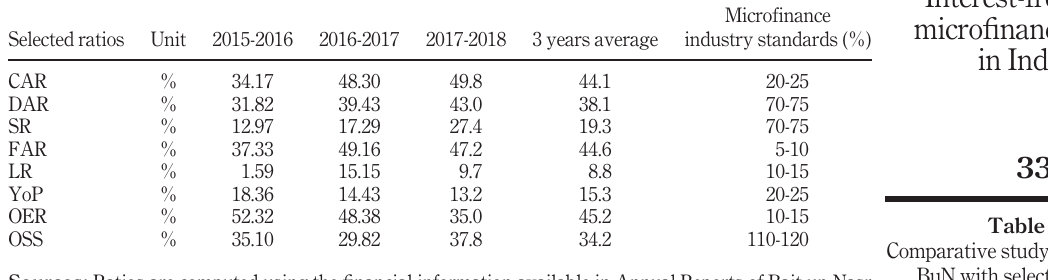
Table II. Comparative study